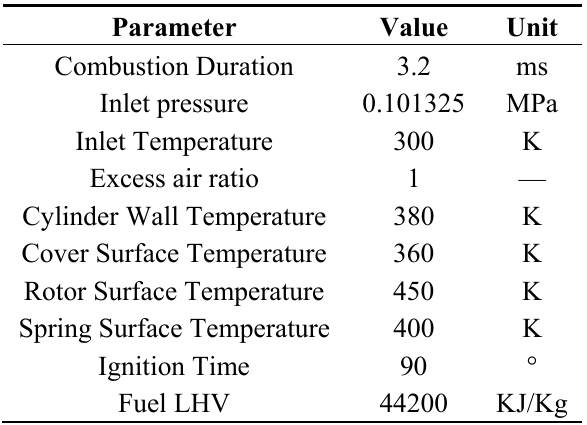
Table 1. Initial conditions and boundary